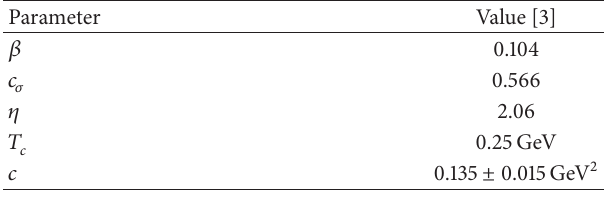
Table 2: The screening mass in the lattice QCD with 𝑁 𝑓 = 3.0 and the present work.